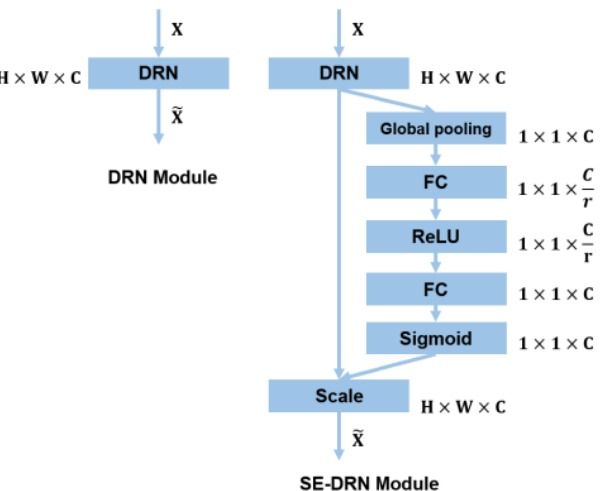
Figure 6. The dimensional change graph of the original DRN ( left ) and the SE-DRN module ( right ).